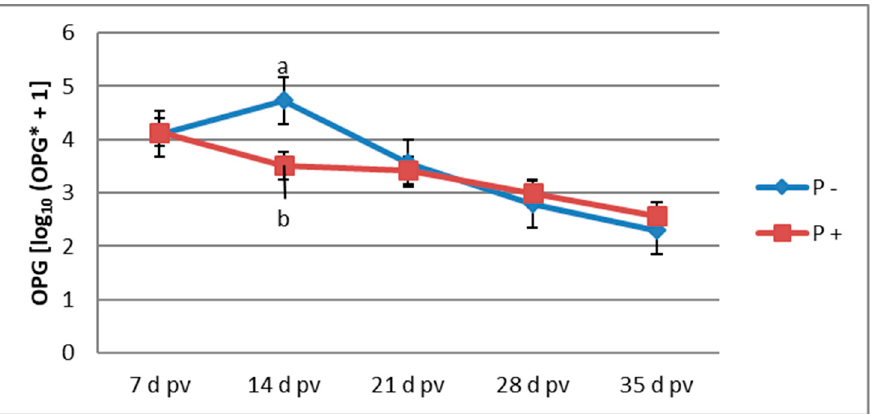
Figure 1. Oocyst shedding in the vaccinated groups [log 10 (OPG + 1]; ( n = 6); a, b—mean values followed by different letters differ significantly at p ≤ 0.05; OPG*—oocysts per gram; pv—post- vaccination; P—probiotic preparation.